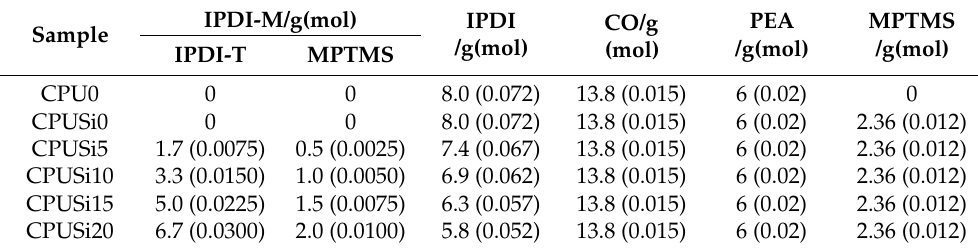
Table 1. The composition of raw material employed for the preparation of CPUSi.